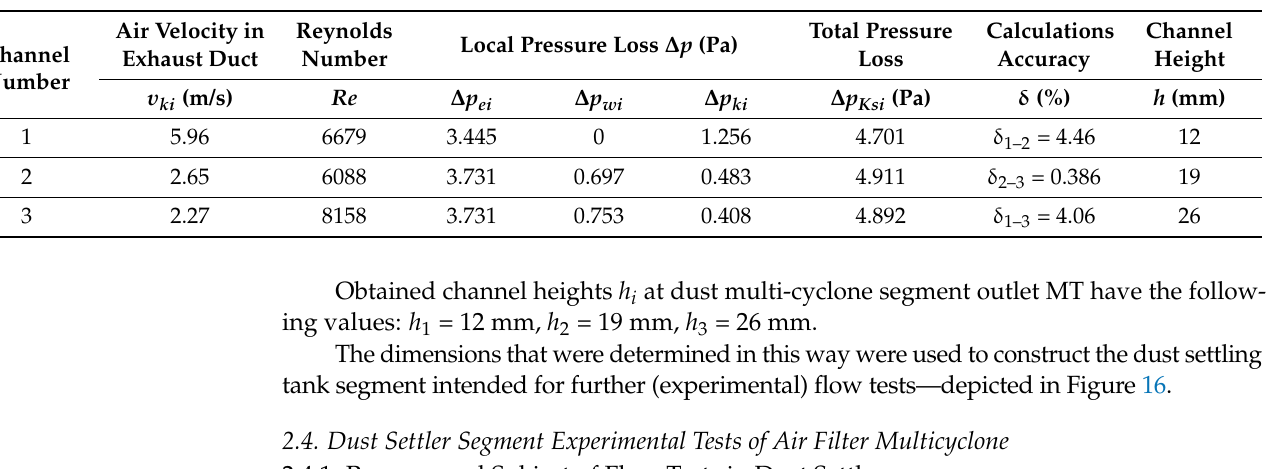
Table 2. Numerical calculations results for dust settling tank segment in multi-cyclone